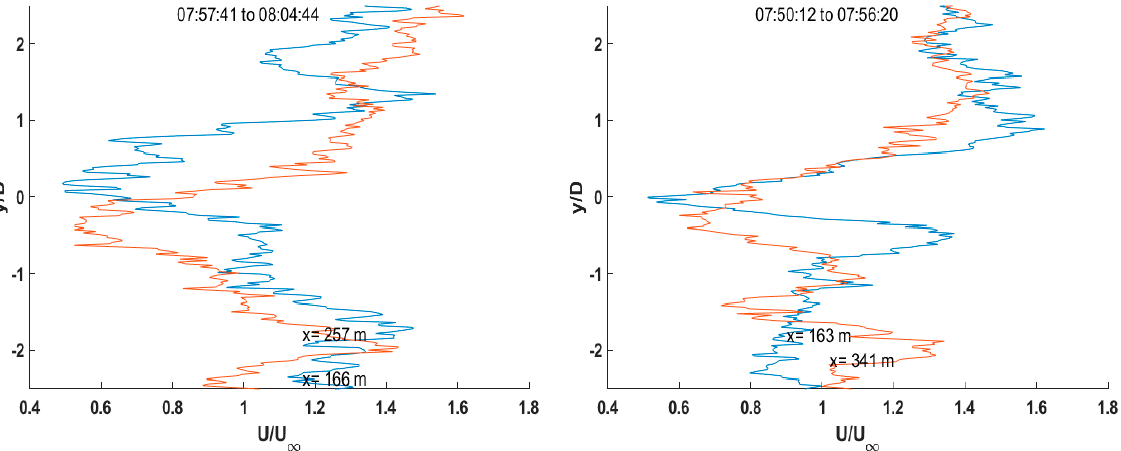
Figure 7. Instantaneous wind speed normalized by the mean wind speed upstream of the turbines U ∞ vs. the distance along the T1-to-T3 axis normalized by rotor diameter D. Two series are repre- sented on each graph. The blue corresponds to the run at the closest distance to the T1-to-T3 axis ( x = 166 and 163 m) and the orange is farther out in the wake ( x = 257 and 341 m). Left: runs at a 90 m agl. Right: runs at a 110 m agl.